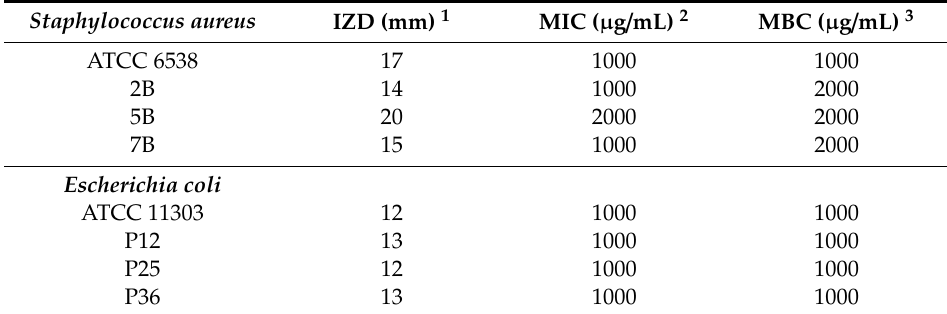
Table 2. Antibacterial activity of the EOOG against S. aureus and E. coli strains by the paper disk diffusion test and the microdilution method.